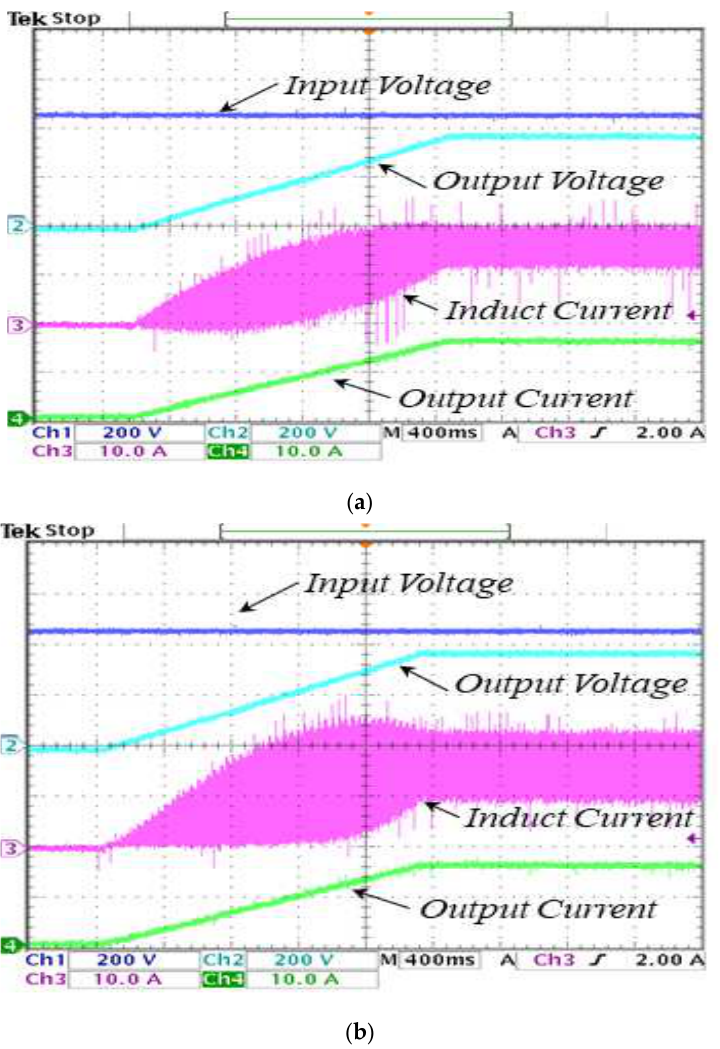
Figure 14. Load soft-start character. ( a ): Experimental results of exit converter . ( b ): Experimental results of the proposed converter.